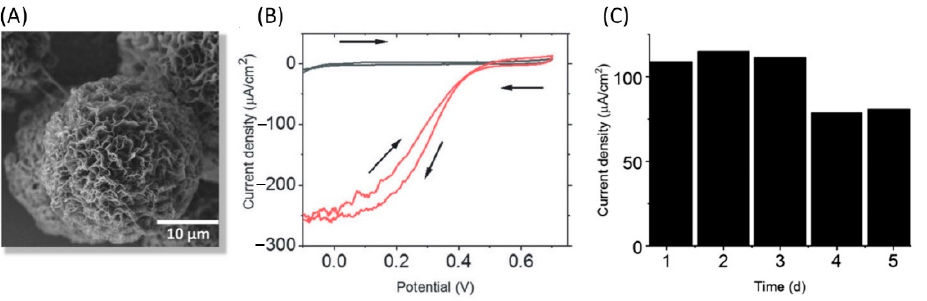
Figure 12. LAC assembled through Cu-flower like particles displays direct and stable electrocatalysis of O 2 reduction. ( A ) SEM image of a Cu/LAC nanoflower, ( B ) Catalytic reduction of O 2 (red curve) by LAC in Cu nanoflowers on CNTs, ( C ) Operational stability. Adapted with permission from